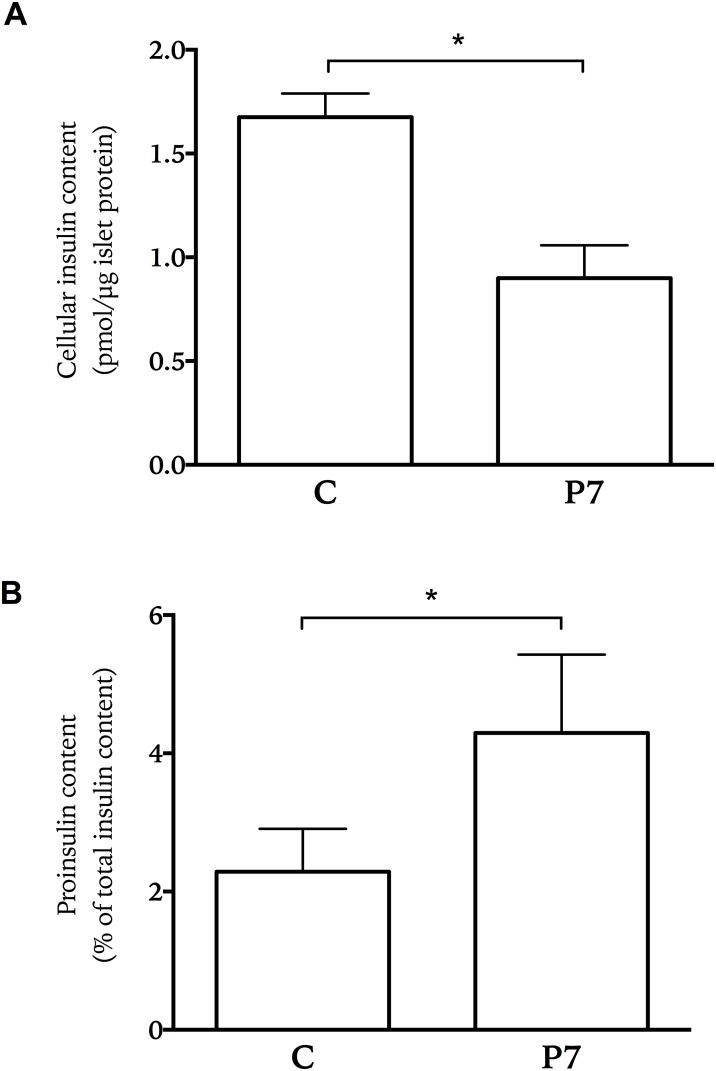
Insulin and proinsulin content in human islets treated with palmitate.Islets were treated for seven days with palmitate (P7). Subsequently, insulin and proinsulin content was measured. Results show means ± SEM as fold control (fold change of control) from 4 donors. * P<0.05 vs control.